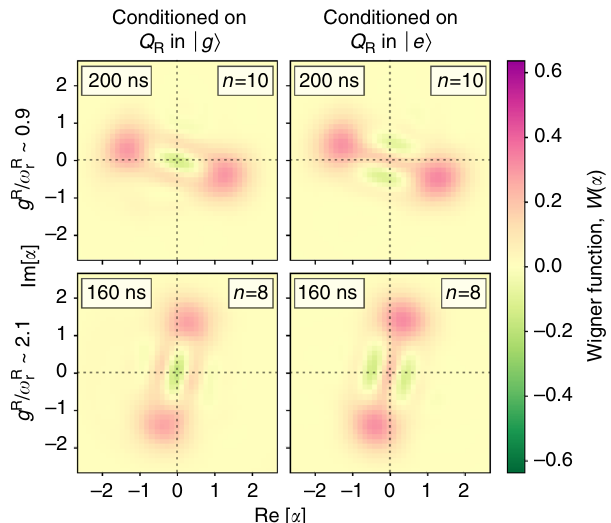
Fig. 5 Nonclassical resonator cat states from conditioned DSC-driven entanglement (degenerate-qubit case). The plots show Wigner functions of nonclassical Schrödinger cat states in the Rabi resonator, reconstructed from maximum-likelihood state tomography for two different DSC coupling (cid:1) 0 : 9 (top, n = 10 Trotter steps) and g R = ω R (cid:1) 2 : 1 strengths with g R = ω R r r (bottom, n = 8 Trotter steps), conditioned on measuring Q R in 0 j i (left) and 1 j i (right). The regions of negativity and visibility of several fringes between the well-resolved coherent state peaks are clear signatures of nonclassicality in the Rabi fi eld mode and demonstrates the coherence and entanglement of the underlying qubit-resonator state. Combined with the qubit conditioning shown in Fig. 4, observing clear cat states for both outcomes of the Q R measurement is a clear signature of coherent DSC